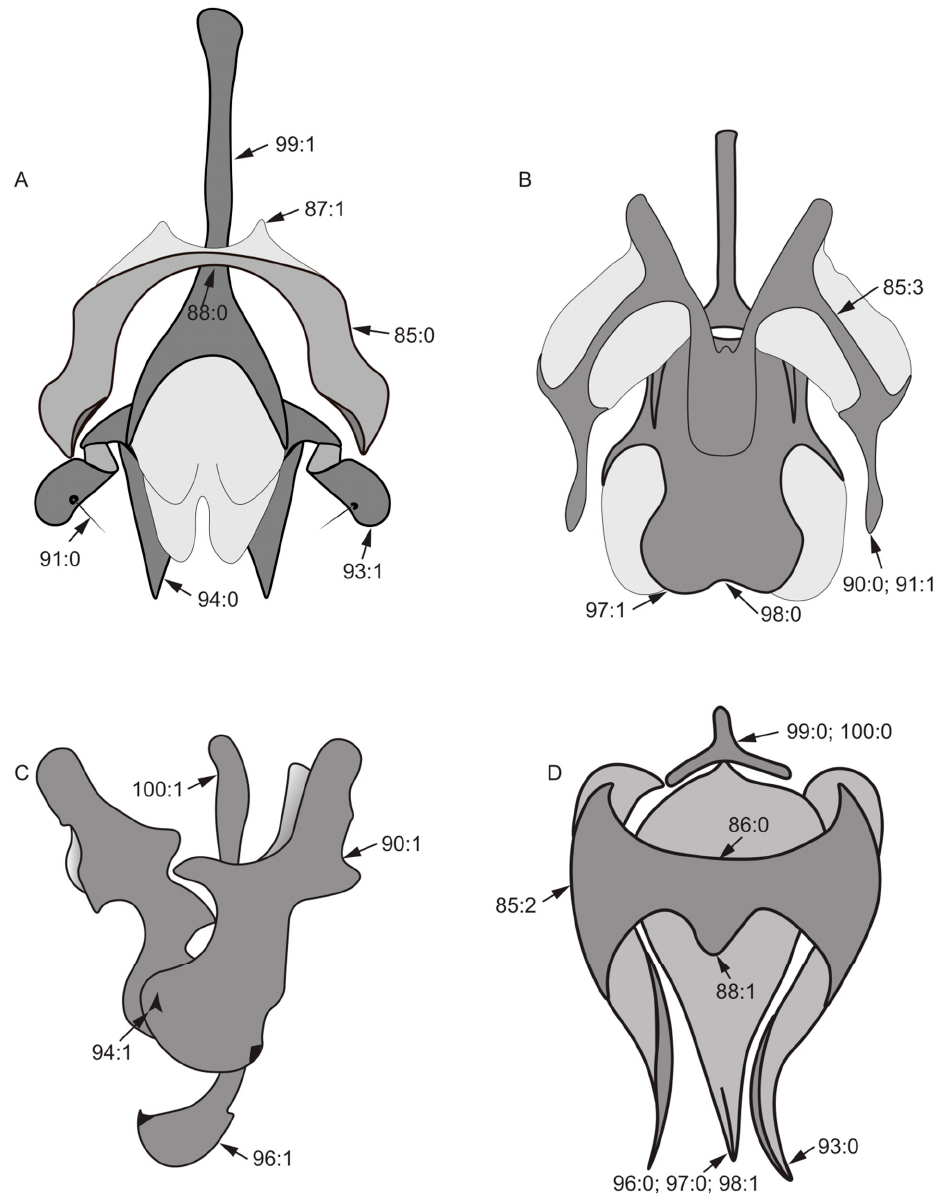
Figure 8. Aedeagal complex characters. ( A ): Noonamyia umbrellata ; ( B ): Homoneura ( Homoneura ) beckeri ; ( C ): Pachycerina decemlineata ; ( D ): Homoneura (Homoneura) procerula . 89. Both sides posterior margin of hypandrium: (0) without ventral process; (1) with ven- tral process (Figure 6D). 90. Gonite: (0) present (Figure 8B); (1) absent (Figure 8C). 91. Seta on gonite: (0) present (Figure 8A); (1) absent (Figure 8B).